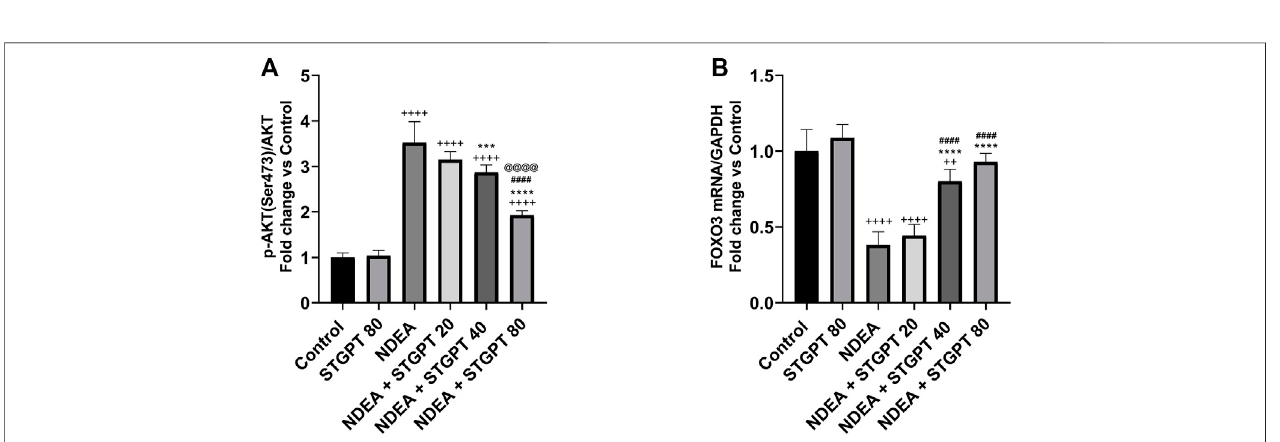
FIGURE5| EffectofSTGPT(20,40and80 mg/kg)onp-AKT(ser473)/AKT (A) ;andFOXO3mRNA (B) inmicewithNDEA-inducedHCC.Dataarepresentedasthe mean ± SD( n (cid:1) 6). ++ p < 0.01 vs. Controlgroup, +++ p < 0.001 vs. Controlgroup, ++++ p < 0. vs. vsControlgroup,*** p < 0. vs. NDEAgroup,**** p < 0.0001 vs. NDEAgroup, #### p < 0. vs. STGPT 20 group, @@@@ p < 0.0001 vs. STGPT 40 group. Control, normal control group received the vehicle; STGPT 80, normal group received sitagliptin (80 mg/kg); NDEA, NDEA-induced HCC group received the vehicle; NDEA + STGPT 20, NDEA-induced HCC group treated with sitagliptin (20 mg/kg); NDEA + STGPT 40, NDEA-induced HCC group treated with sitagliptin (40 mg/kg); NDEA + STGPT 80, NDEA-induced HCC group treated with sitagliptin (80 mg/kg).